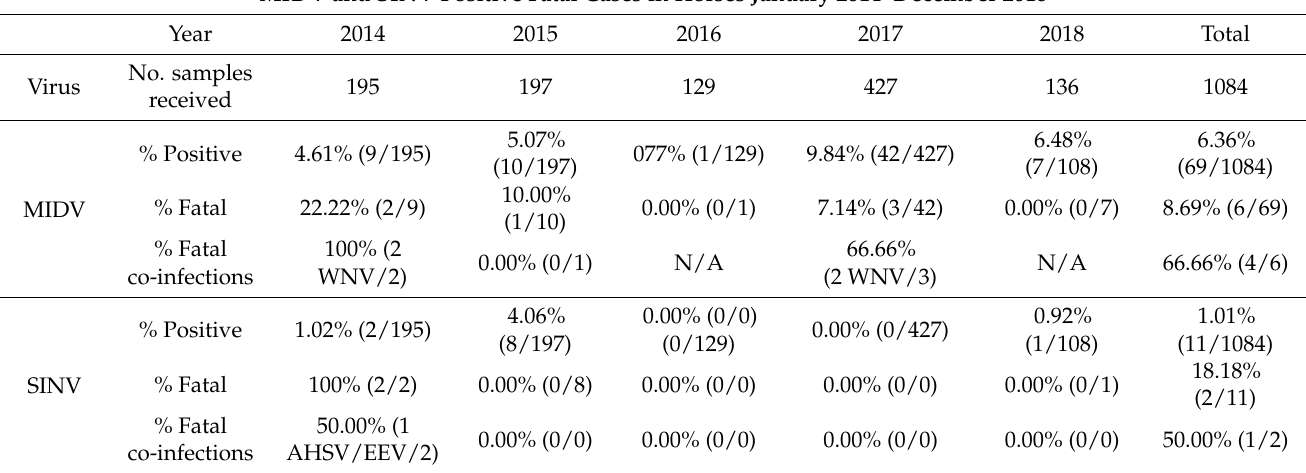
Table 2. Summary of MIDV and SINV detected in fatal cases in horses from South Africa